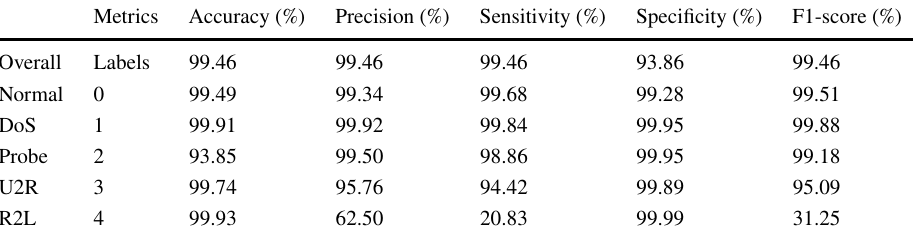
Table 14 Evaluation metrics after feature selection of the